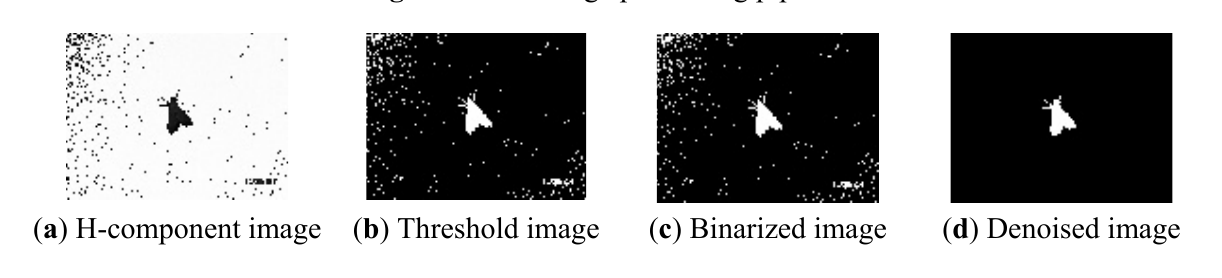
Figure 8. The image processing